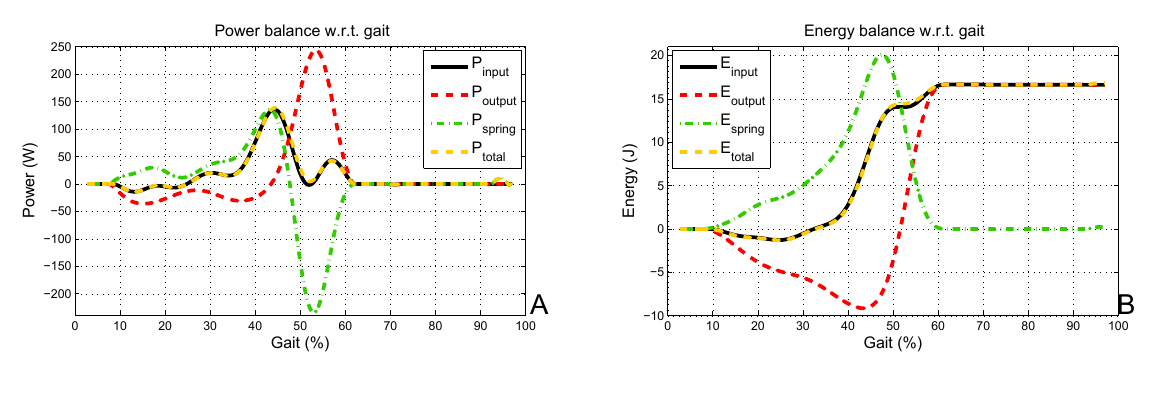
The power balance in (A) shows that P P . The same goes for the energy balance in (B). Both balances are for a stiffness of output k = 155,000 N SEA m